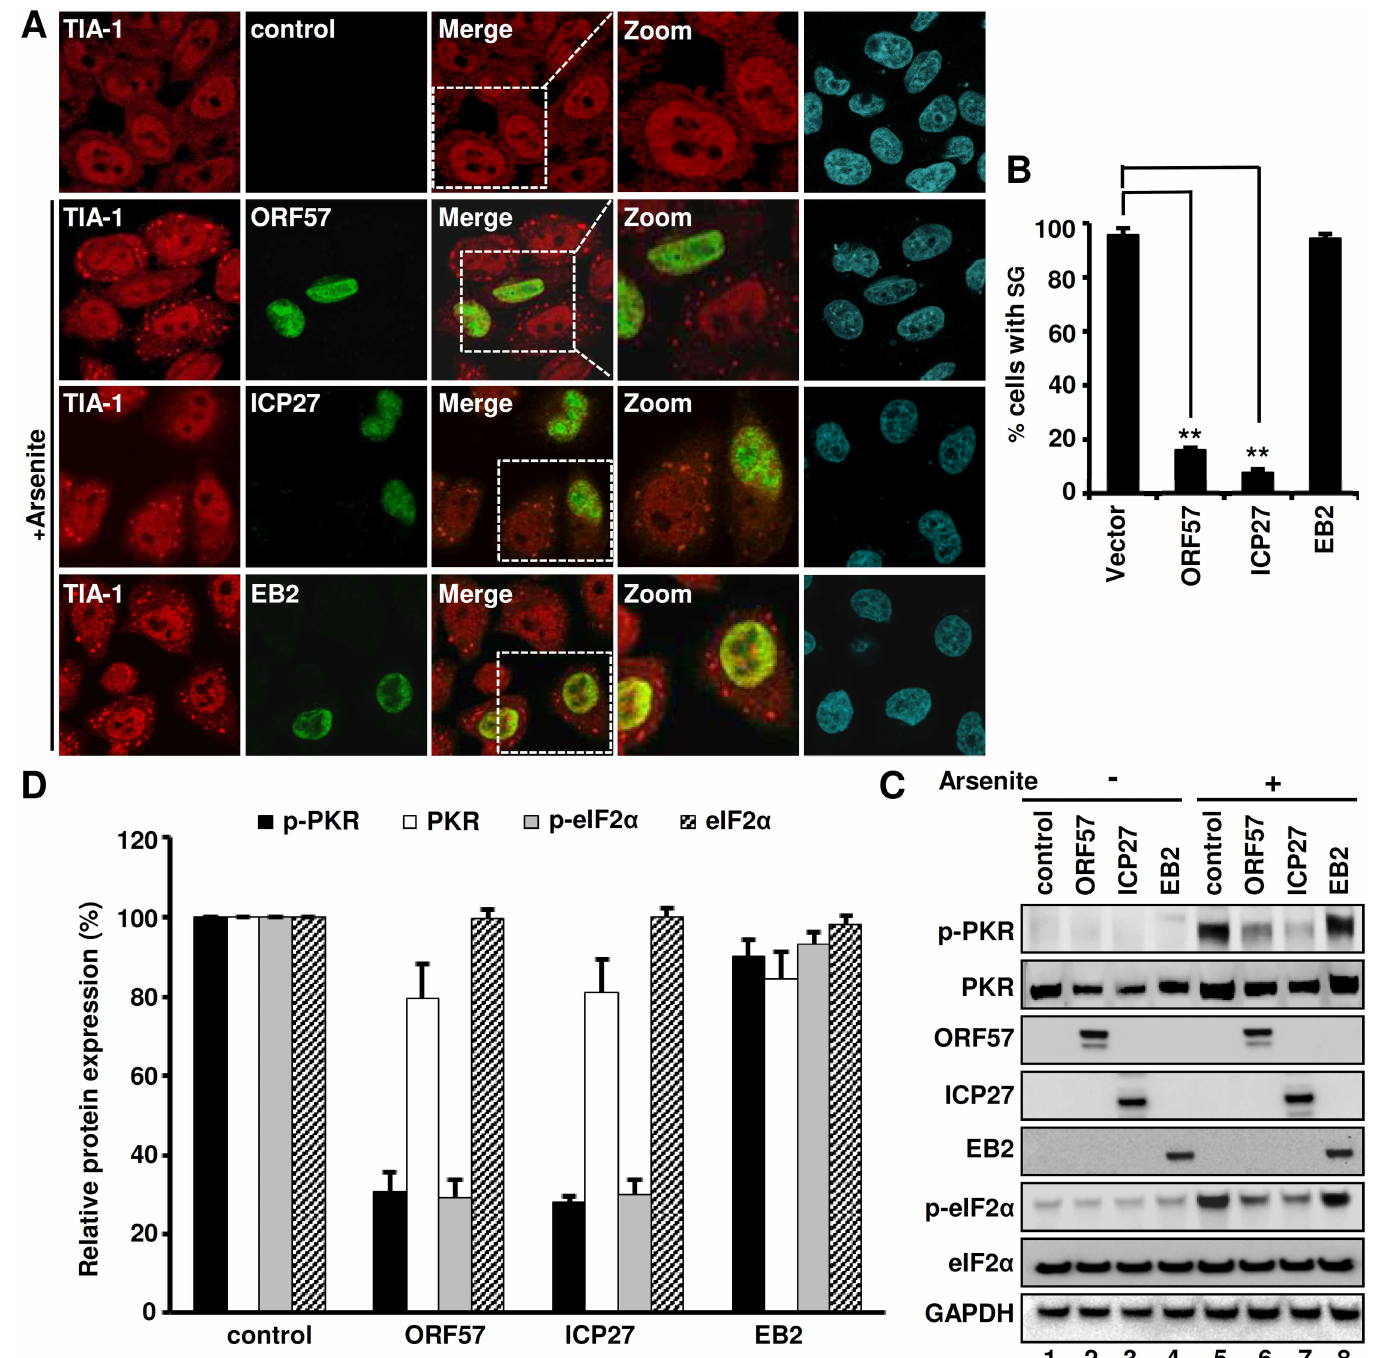
Fig 11. Differential function of KSHV ORF57 and its homologs in the herpesvirus family in inhibition of PKR-eIF2 α pathway and SG formation. (A-B) HSV-1 ICP27, but not EBV EB2, inhibits SG formation in HeLa cells. HeLa cells expressingORF57-Flag, ICP27-Flag, or EB2-Myc were treated with 0.5 mM arsenite for 30 min to induce SG. The cells were stained with anti-TIA-1 (Red) for SG, and anti-Flag (green)for ORF57 and ICP27 or anti-Myc (green)for EB2 (A). The nuclei were counterstained with Hoechst. Images were captured using confocalmicroscopy.Scale bar = 10 μ m. Bar graph (B) shows at least 100 cells in each group with or without a viral protein being analyzedfor SG-positive cells, with mean ± SD from three independent experiments. ** P < 0.01in Chi-squared test. (C-D) HSV-1 ICP27, but not EB2, inhibits phosphorylation of endogenous PKR and eIF2 α . HeLa cells at 24 h of transfectionwith each viral protein expressingvector or a Flag empty control vector were treated with 0.5 mM arsenite for 30 min and blotted with a correspondingantibodyfor each protein, anti-Flag for ORF57-Flag and ICP27-Flag and anti-Myc for EB2-Myc (C). GAPDH served as a loadingcontrol. The relativelevels of p-PKR, PKR, p- eIF2 α and eIF2 α to GAPDH level were calculatedover the amount of each protein from the vector control and shown in bar graphs(D), with mean ± SD from three independentexperiments.